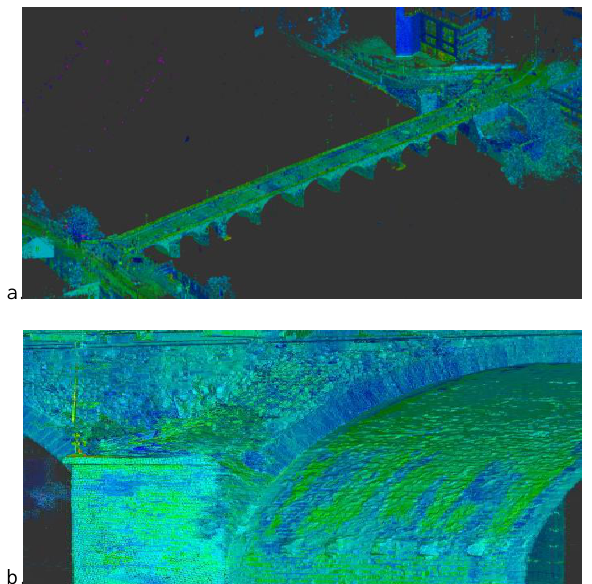
Figure 2. Some images of the laser scanning survey: the overall bridge (a) and a detail of the intrados of a volt (b).